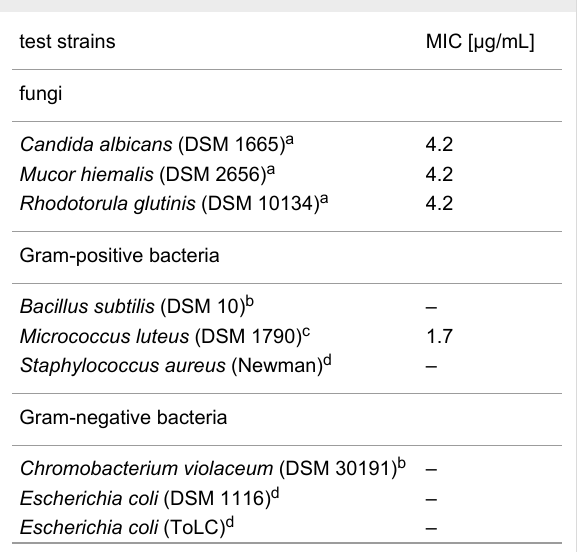
Table 2: Atom distances in the 3D model for selected ROESY correla- tions observed in lanyamycin ( 1 / 2 ). atom 1/atom 2 distance [Å] Table 3: Antimicrobial activity of lanyamycin ( 1 / 2 ).